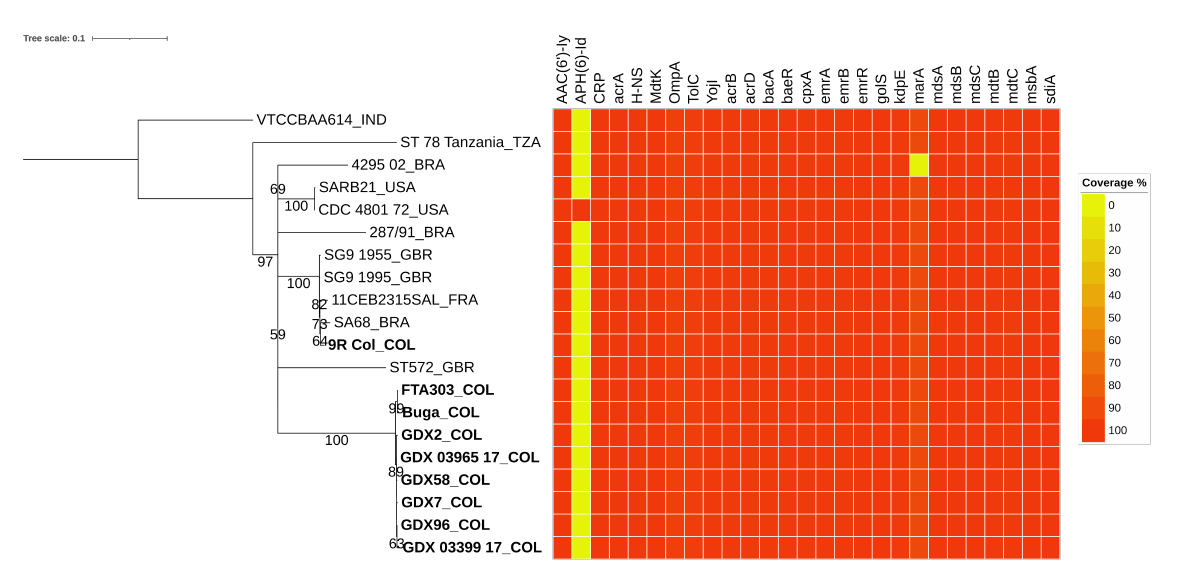
Figure 1. Phylogenetic tree based on a core SNP alignment was performed with RaxML-NG v1.1.0 [35] based on the TVM model and 1000 bootstrap replications. Left : The tree was visualized and annotated using ITOL v6 [36]. Right : Chromosomal genes associated with antimicrobial resistance (AMR) in the studied SG strains. The color range bar represents the % coverage concerning the CARD reference.